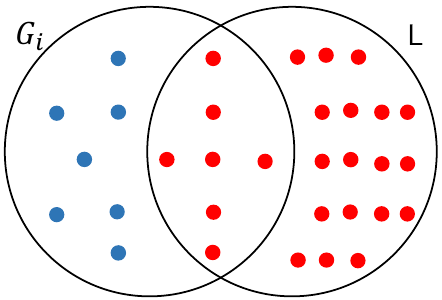
Figure 2. An example of coverage score. Differentially expressed genes are shown as red circles. f ( G i , L ) = 1 ; i.e., 50% of genes in G i are differentially 2